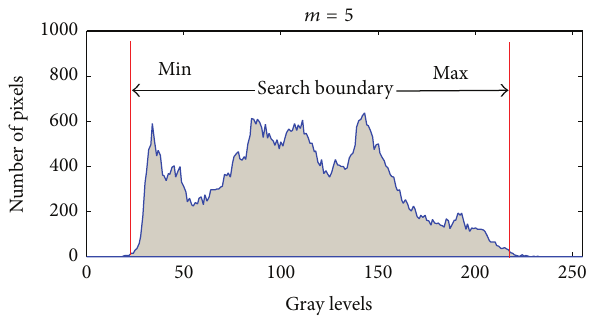
Figure 5: Histogram with possible search